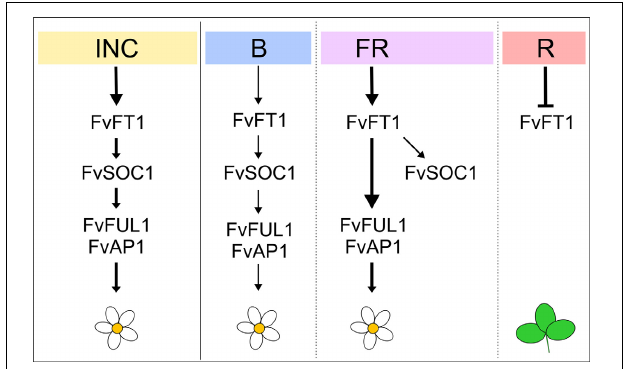
FIGURE 6 | Model showing the regulation of flowering by light quality in the F. vesca . Daylength extension with incandescent light (INC) promotes flowering through the up-regulation of FvFT1 and FvSOC1 in the perpetual flowering F.vesca accession Hawaii-4 (Mouhu et al., 2013). These genes are essential also for the promotion of flowering by the end-of-day blue (B) light. Under FR light, however, FvFT1 induces flowering independently of FvSOC1, whereas R (red) light down-regulates FvFT1 and prevents flower induction. In the SD F. vesca , FvTFL1, a strong floral repressor that functions downstream of FvFT1 and FvSOC1, reverses the responses to different light qualities. Arrows indicate activation, and bars indicate repression. Thicker line indicates stronger response.